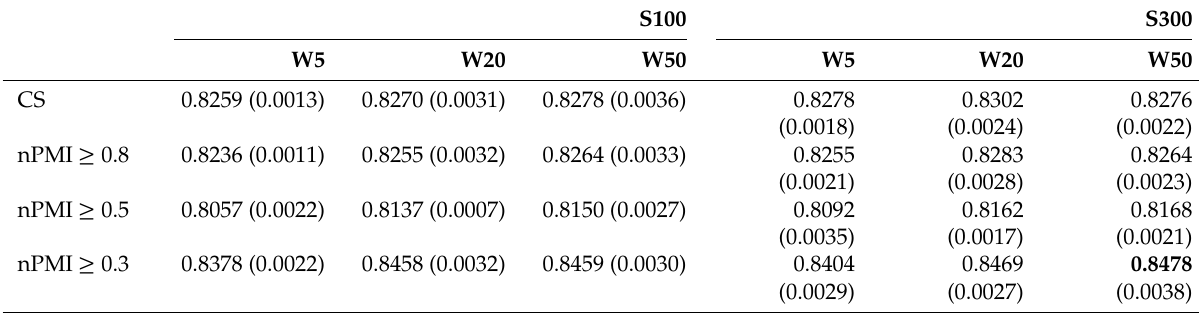
Table 7: Knowledge-based WSD accuracies (standard deviations) using CUI association values (MeSH term co- occurrences), CUI definitions (UMLS), and word embeddings.